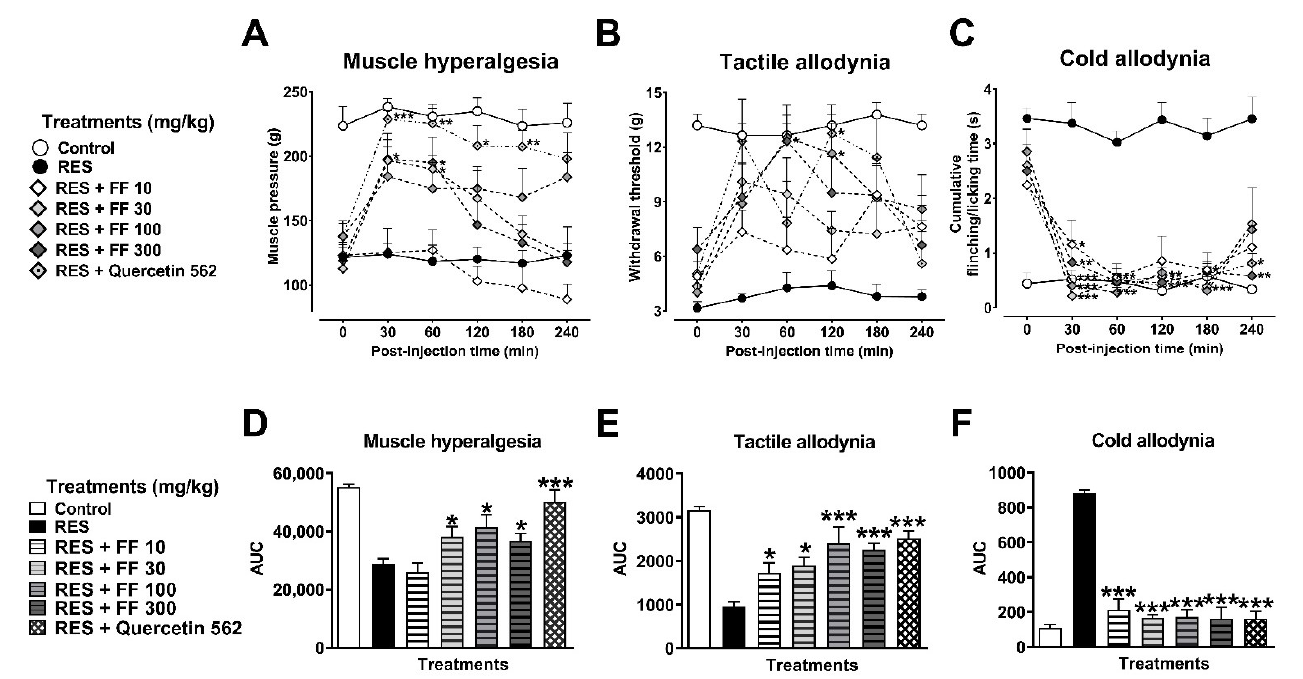
Figure 5. Antihyperalgesic and antiallodynic effect of a flavonoid fraction of Tilia (rutin and isoquercitrin) on the reserpine (RES)-induced nociceptive threshold. Time-course curves of the threshold for muscle pressure, shown as the force in grams supported in the right gastrocnemius muscle ( A ), the tactile response, shown as the force in grams supported on the plantar surface of the right hind limb ( B ), and cold allodynia, shown as the cumulative response time to cold stimulus (acetone) on the dorsal surface of the right hind limb for 1 min ( C ). Area under the curves of the muscle pressure threshold ( D ), tactile response ( E ), and cold allodynia ( F ). One-way ( D – F ) or two-way ( A – C ) ANOVA followed by Tukey ´ s test, * p < 0.05, ** p < 0.01, *** p < 0.001 vs. RES